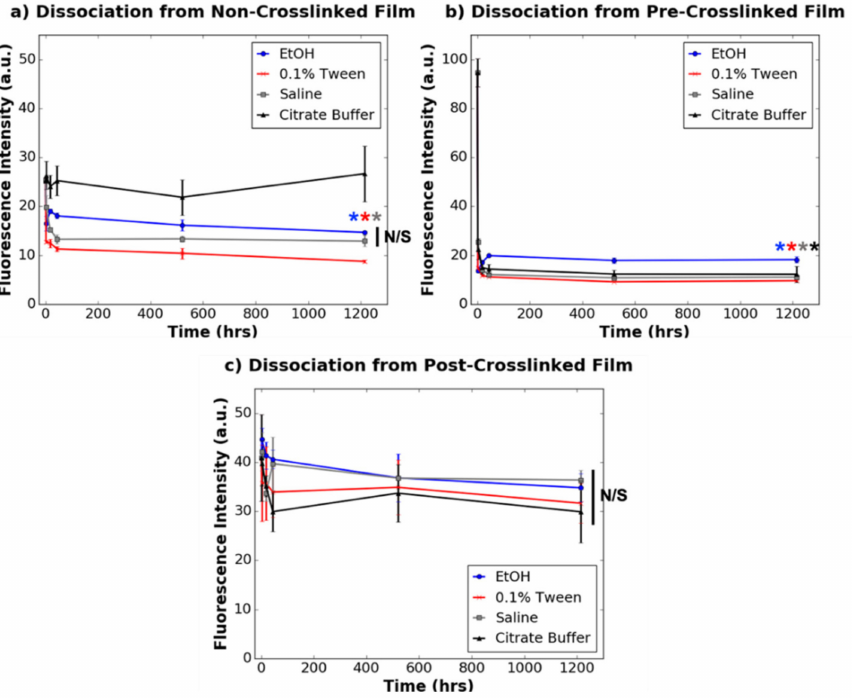
Figure 3. Dissociation of 78% dye-tagged dendrimers (0.77 µ g/mg loading concentration) from ( a ) non-crosslinked films, ( b ) pre-crosslinked films, and ( c ) post-crosslinked films ( n = 3 for all time points except for time point 0, which was n = 4). N/S denotes p ≥ 0.05. * denotes statistically significant difference ( p ≤ 0.01) between the data point annotated (colour-coded) and the respective 0 h value for each collagen substrate. Statistical significance is only denoted for the final time point for